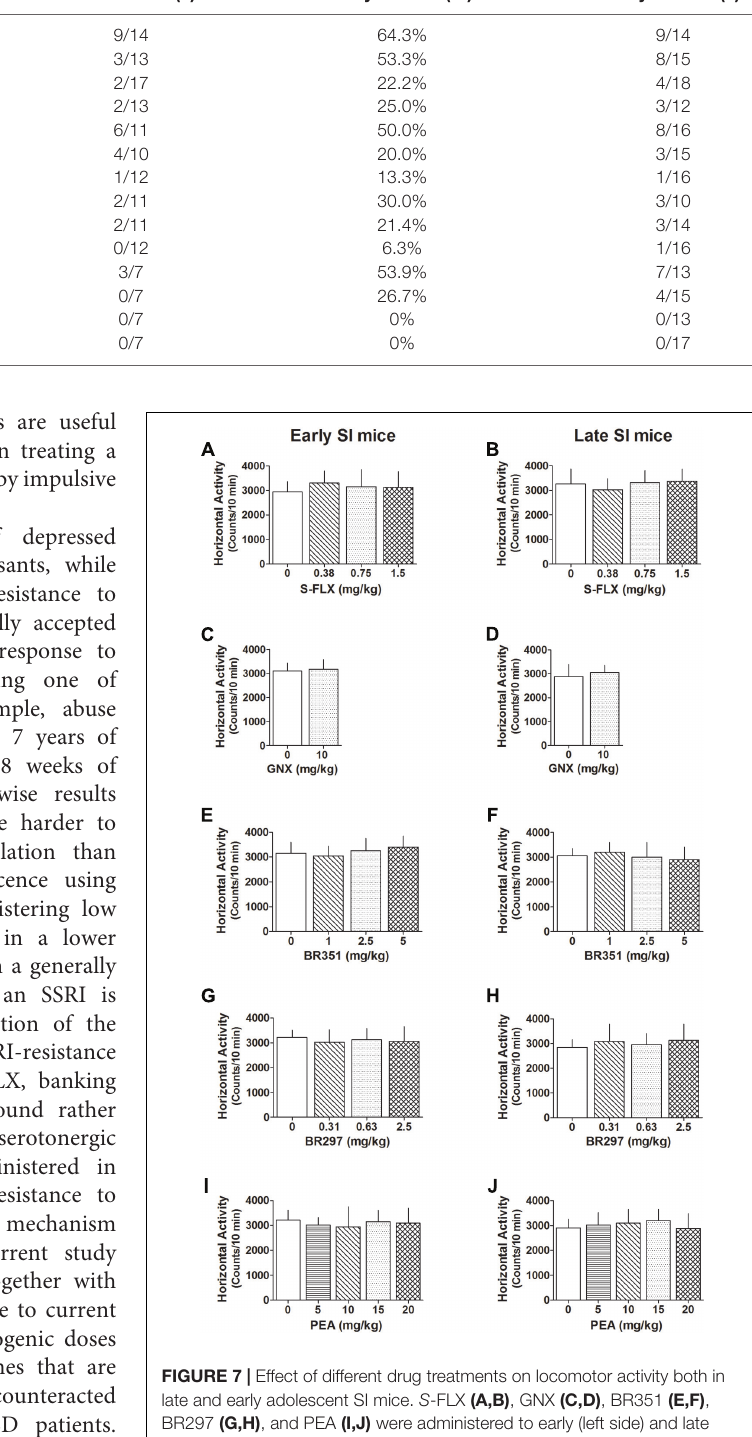
Frontiers in Cellular Neuroscience |